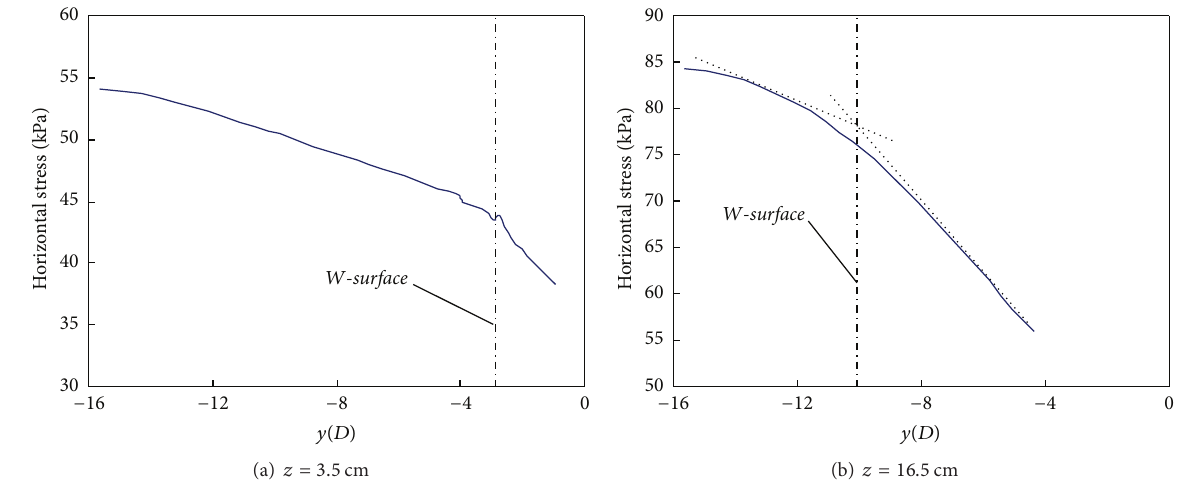
Figure 11: Stress distribution on a horizontal line by numerical analysis.